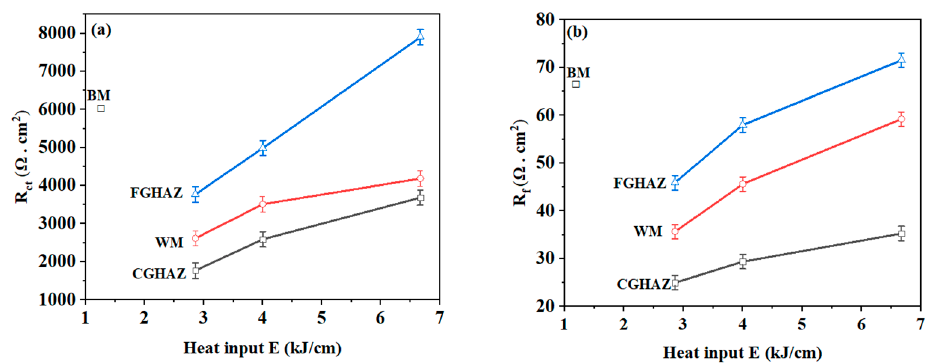
Figure 15. Fitting results of R ct and R f extracted from impedance spectrum curves of different samples: ( a ) heat input and R ct change line chart; ( b ) heat input and R f change line chart.